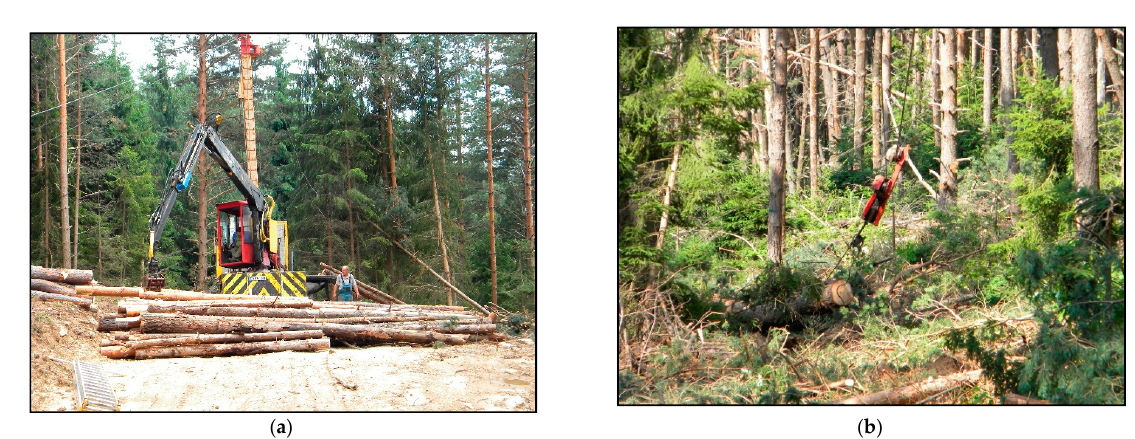
Figure 2. Koller K501 yarder during the operations: ( a ) view from the landing site; ( b ) view from the lateral yarding.